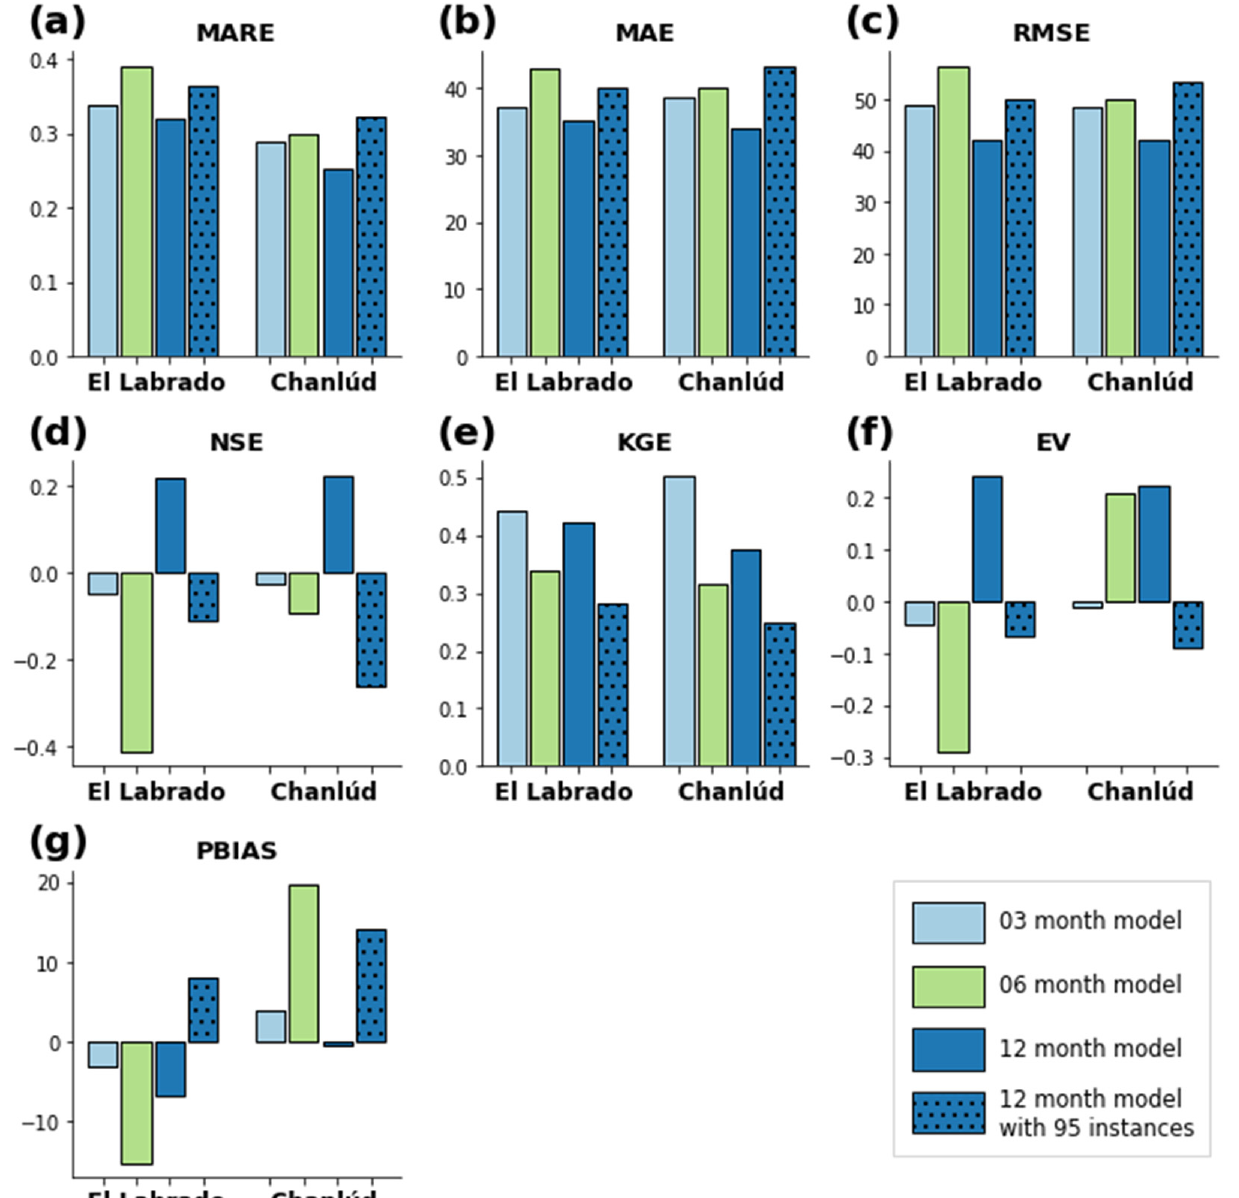
Figure 10. Quantitative evaluation of the models’ performances using the metrics: ( a ) MARE; ( b ) MAE; ( c ) RMSE; ( d ) NSE; ( e ) KGE; ( f ) EV; ( g ) PBIAS. The metrics were calculated using the entire testing period.